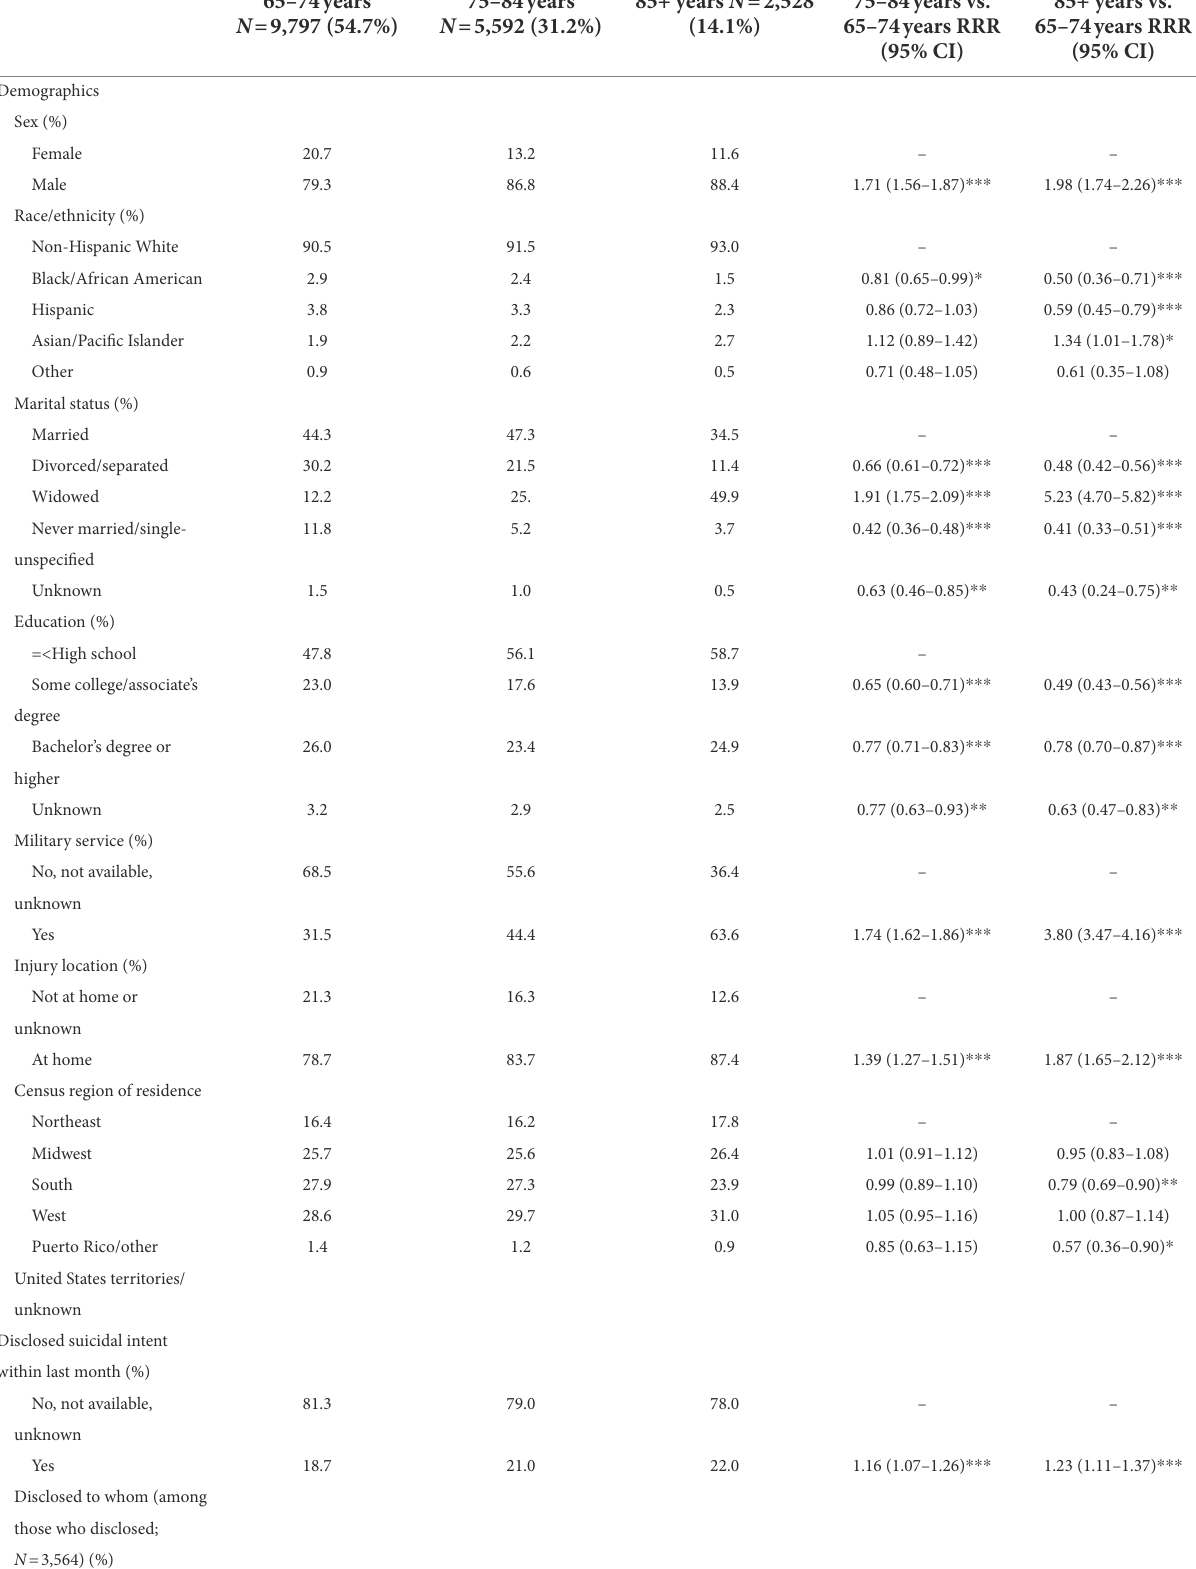
TABLE 1 Demographic characteristics, intent disclosure, and suicide means of suicide decedents age 65+: Results from single-variable multinomial logistic regression